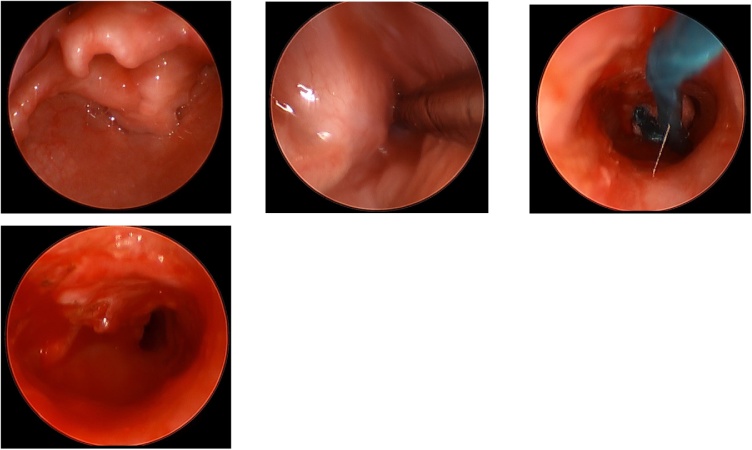
Images – Direct Microlayngoscopy and Rigid Bronchoscopy Showing Grade III Subglottic Stenosis with Suprastomal Granulation in the Proximal Trachea.